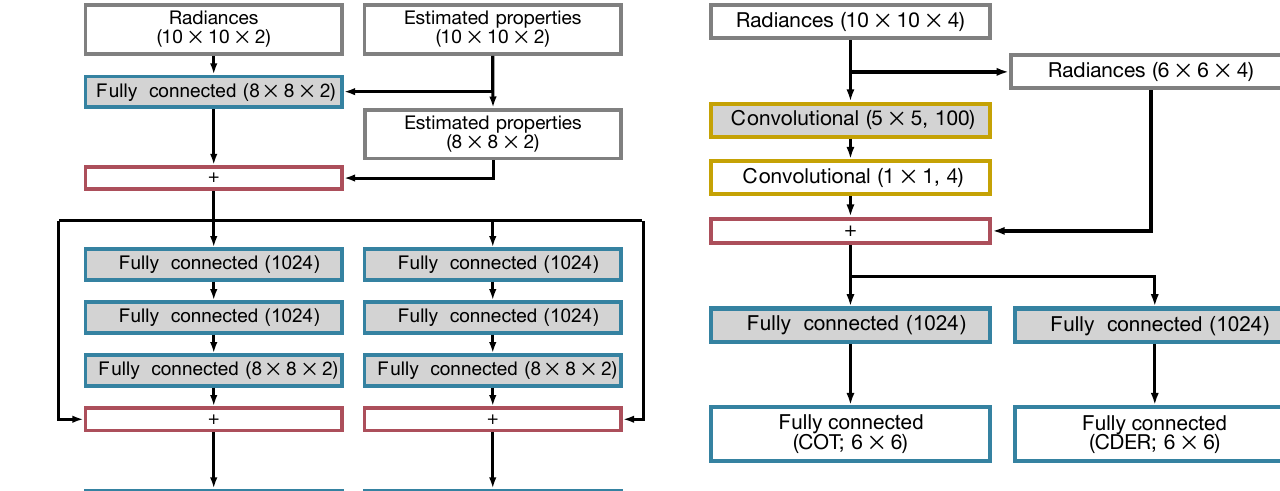
Figure 4. The same as Fig. 3 but for the DNN-4w network. Yellow rectangles denote the convolutional layers, for which the numbers in parentheses denote the filter size and the number of output channels. The number of filters is determined by multiplying the numbers of input and output